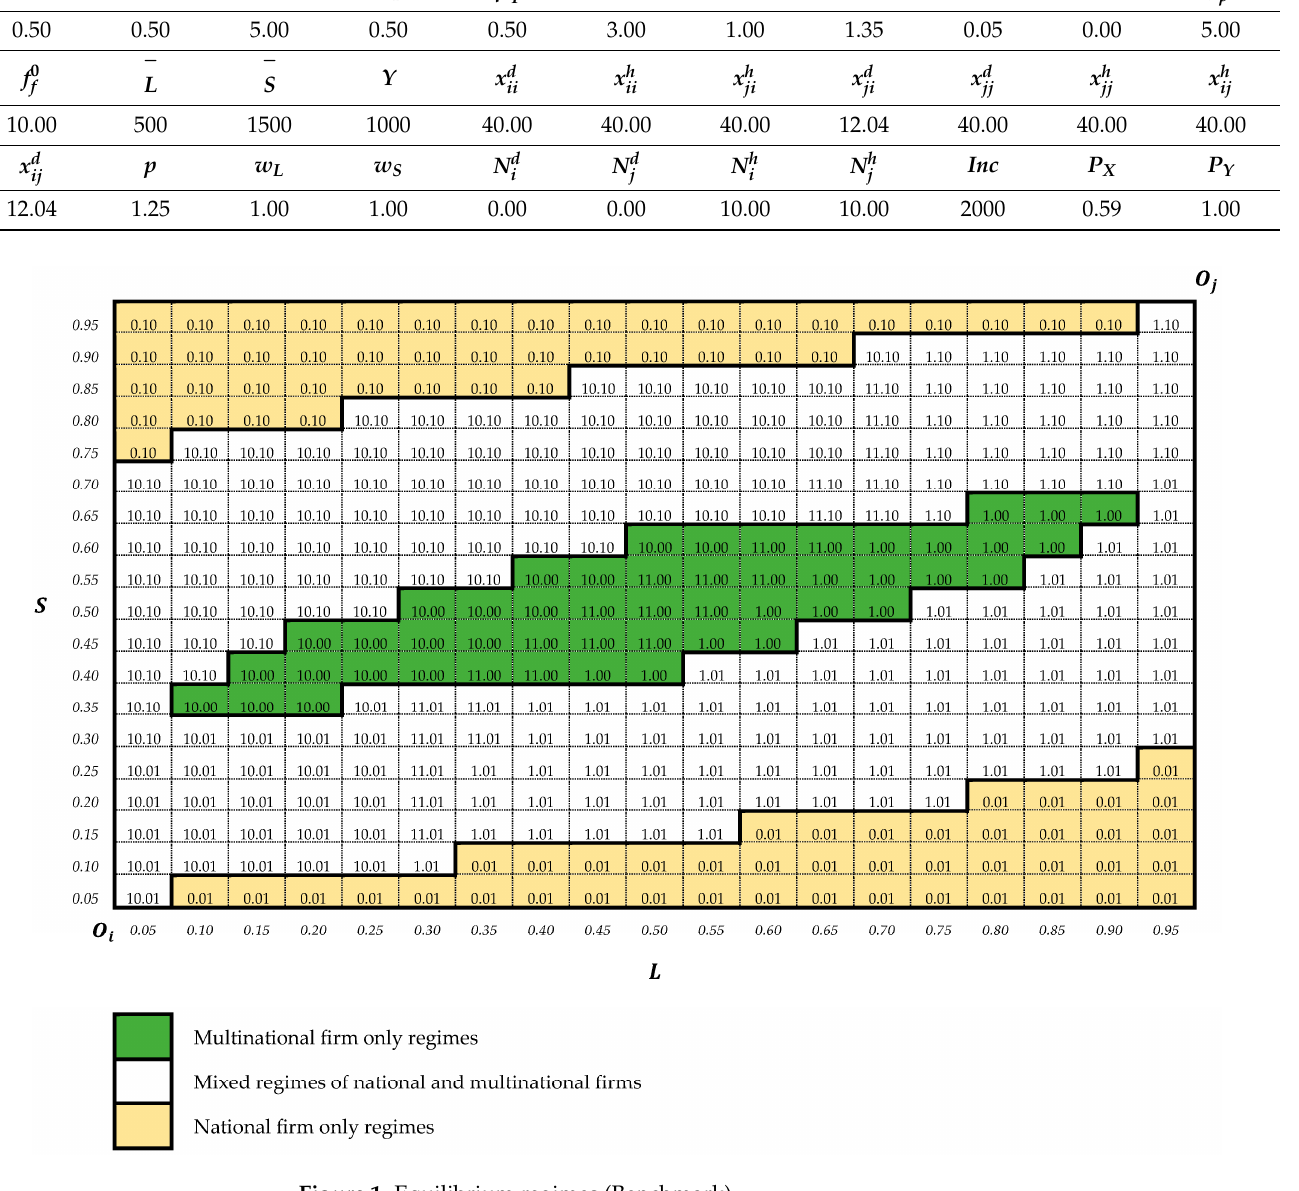
Table 1. Benchmark parameter and variable values.